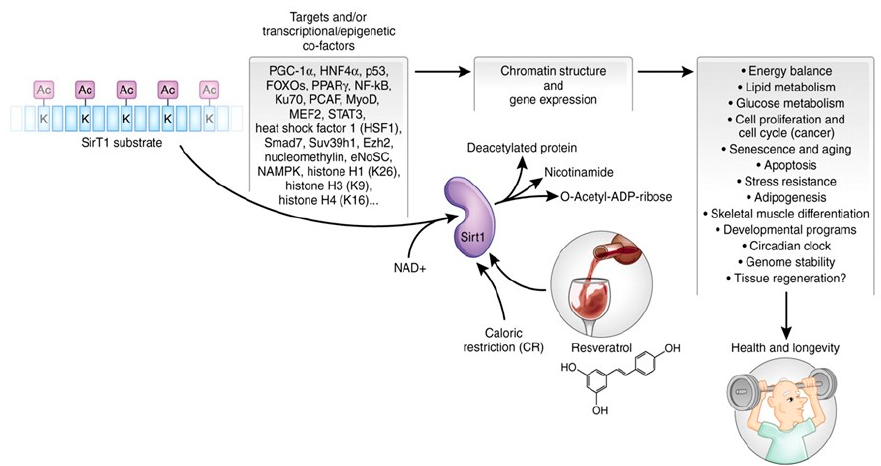
Figure 8. The enzymatic reactions carried out by SirT1, its targets, including transcriptional co-factors, and dependent biological process. SirT1 protein substrate(s) is represented as a string of blue rectangles, with acetylated (Ac) lysine (k) residues. Using NAD + as a co-factor, SirT1 can deacetylate histones, and nuclear and cytoplasmic proteins on specific K residues. This reaction generates a deacetylated protein, nicotinamide and O -acetyl-ADP-ribose (OAADPR). SirT1 activity can be enhanced by caloric restriction (CR) and by the polyphenol resveratrol, affecting multiple developmental, physiological and pathological processes, and ultimately favoring health and increasing longevity. From: Vinciguerra M. et al. Dis. Model. Mech . 2010, 3, 298–303.